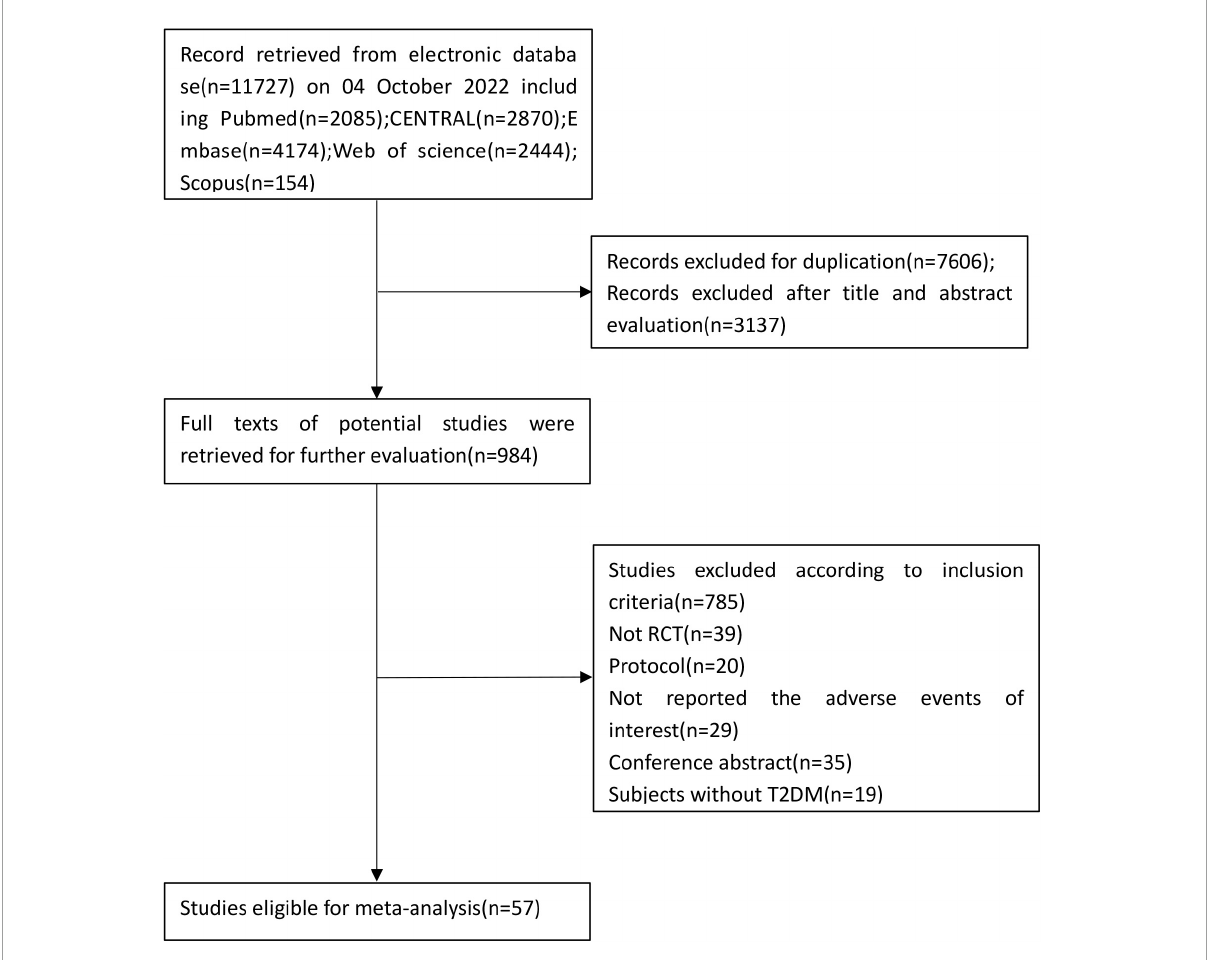
FIGURE1 Flowchart showing identification of the included